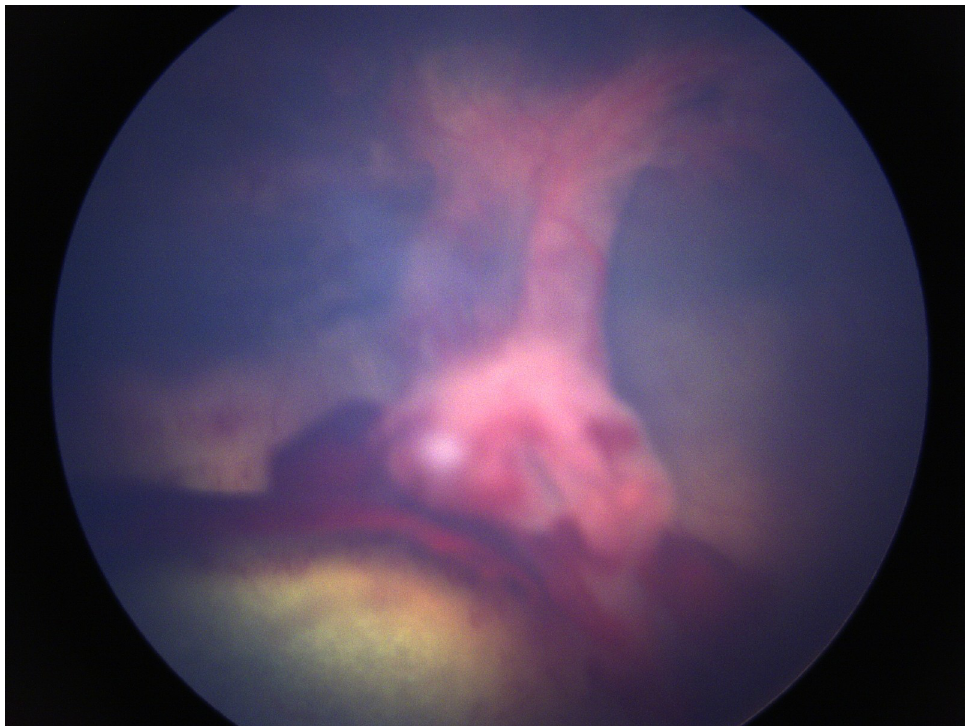
Fig 3. Ocular defects associated with affected ECS. Showing the retinal detachment as a fibrovascular